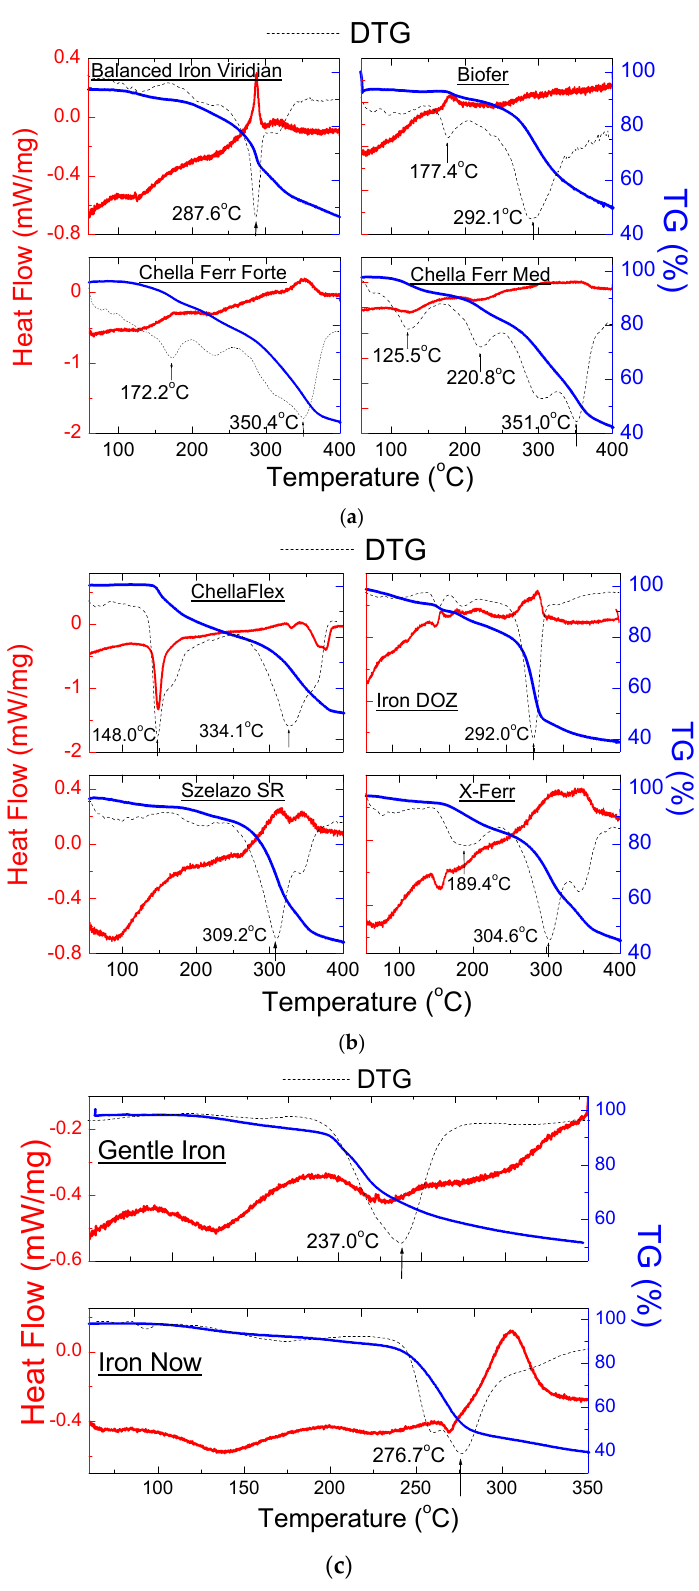
Figure 11. DSC and TG/DTG curves of dietary supplements containing iron (II) bisglycinate: ( a ) Balanced Iron Viridian , Biofer , Chella Ferr Forte , Chella Ferr Med , ( b ) Chella Flex , Iron APTEO , Szelazo SR , X-Ferr , ( c ) Gentle Iron , Iron NOW .